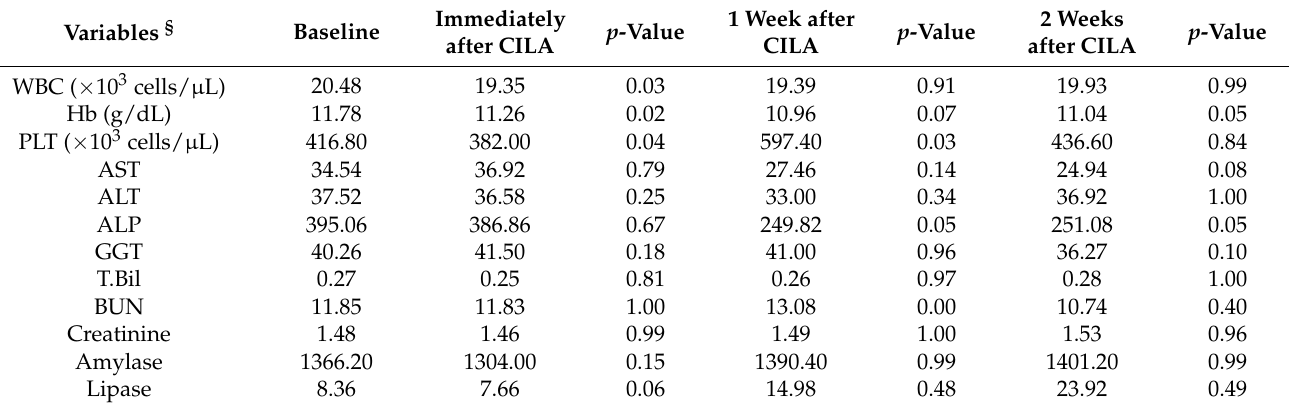
Table 1. Blood test results after EUS-CILA.